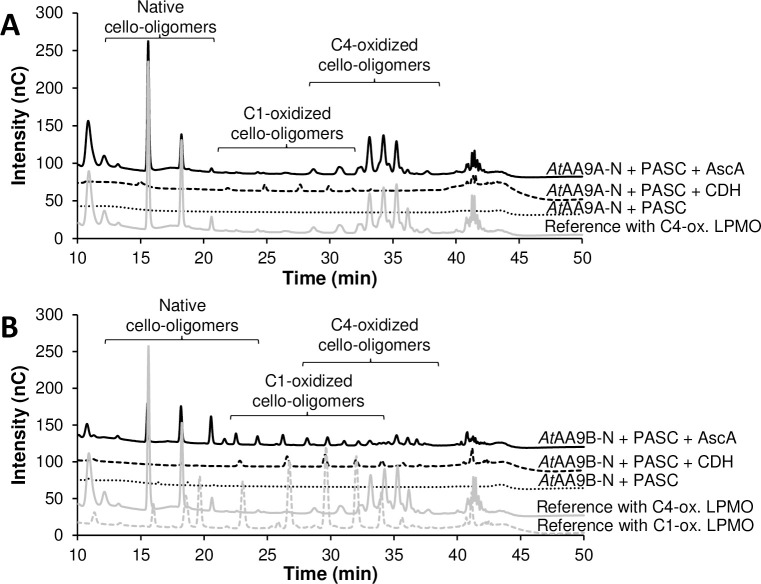
Oxidative cleavage of PASC by (A) AtAA9A-N and (B) AtAA9B-N. The graphs are HPAEC-PAD profiles of reaction mixtures containing 1 μM LPMO and 0.2% (w/v) PASC in 50 mM of BisTris-HCl pH 6.0, without electron donor (dotted black lines), with 1 mM ascorbic acid (AscA) as electron donor (solid black lines) or with 1 μM MtCDH as electron donor (dashed black lines), after incubation at 37°C for 18 h. For identification of C1- and C4-oxidized cello-oligosaccharides, product mixtures generated in reactions with strictly C1-oxidizing 1 μM NcAA9F (dashed grey lines) or strictly C4-oxidizing NcAA9C (solid grey lines), respectively, were used as a reference.